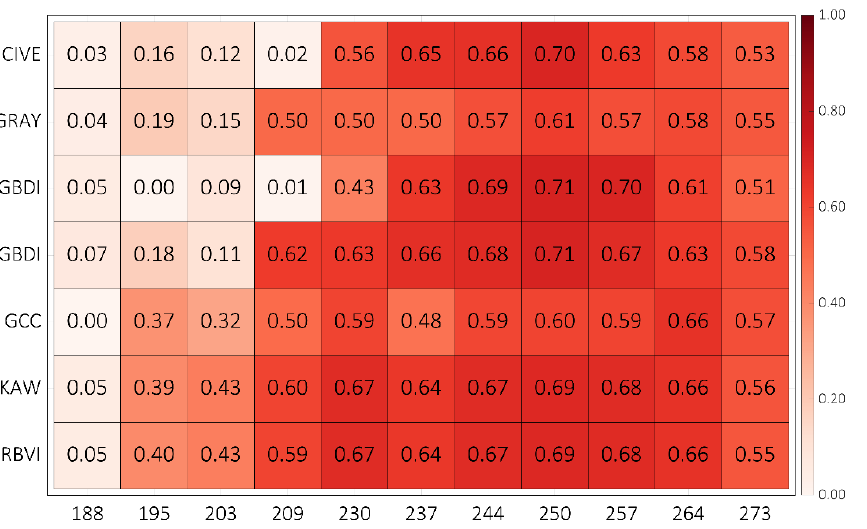
Figure 4. The R 2 between the RGB-based VIs and maize grain yields using data at each growth stage using the linear regression method. The x-axis represents the DOY and the y-axis represents the different indices.